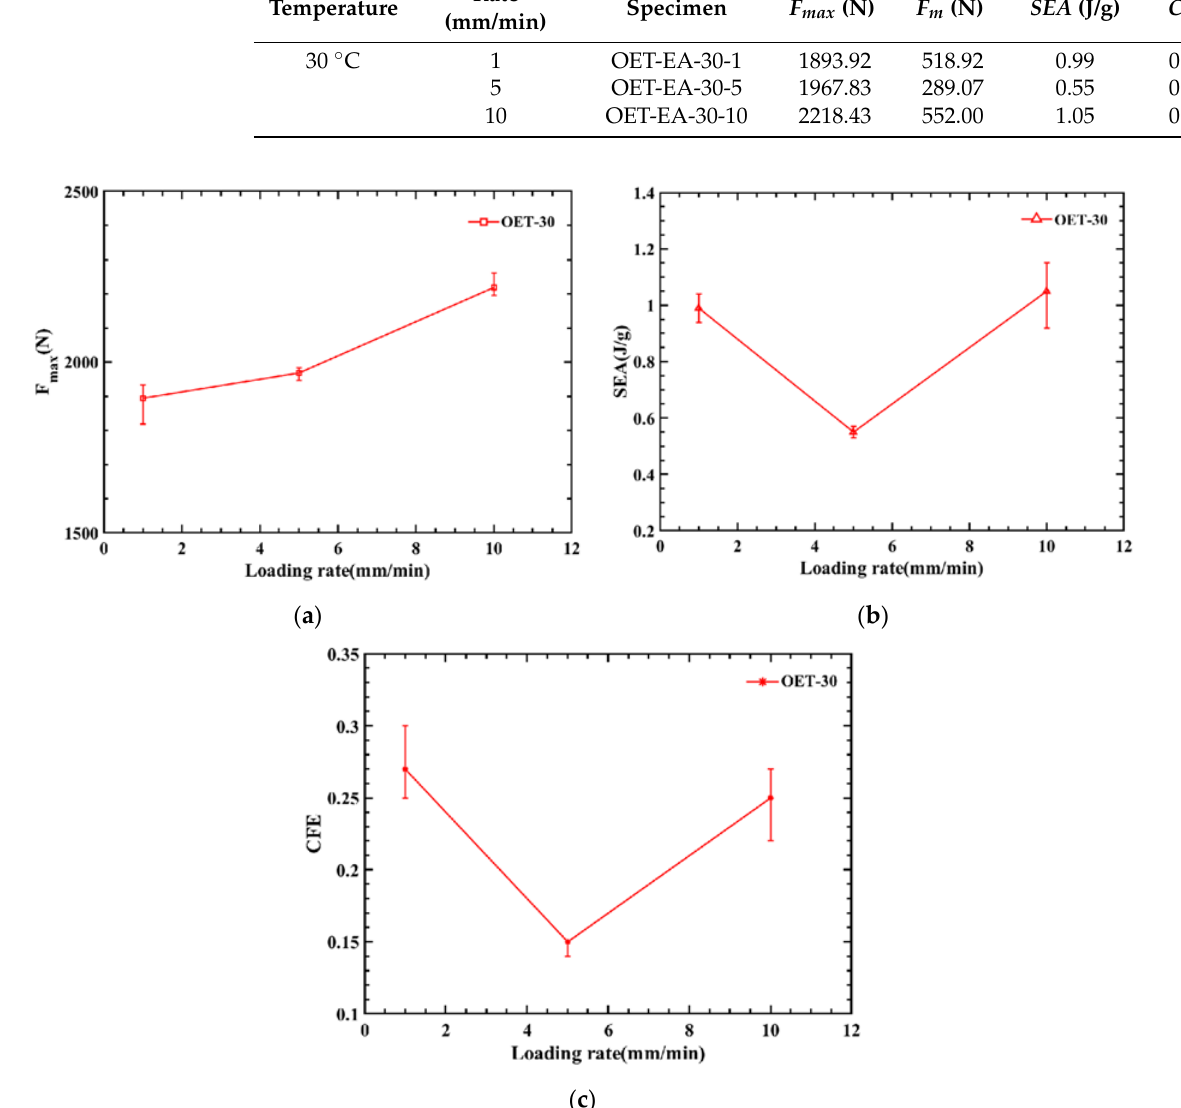
Figure 7. Dynamic performance of OET at different rates: ( a ) F max , ( b ) SEA, and ( c ) CFE.